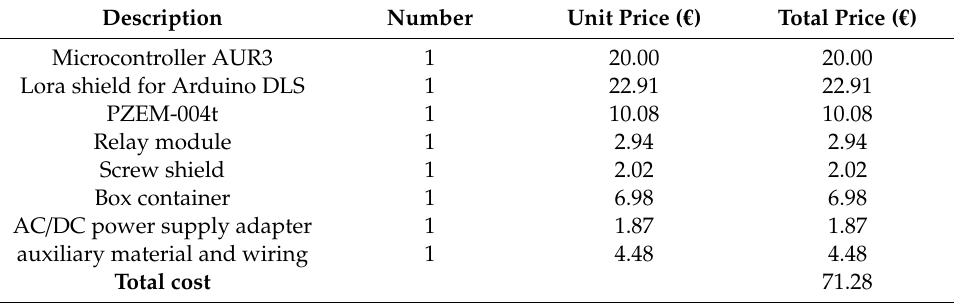
Table 2. IMEMSL without GPS cost.